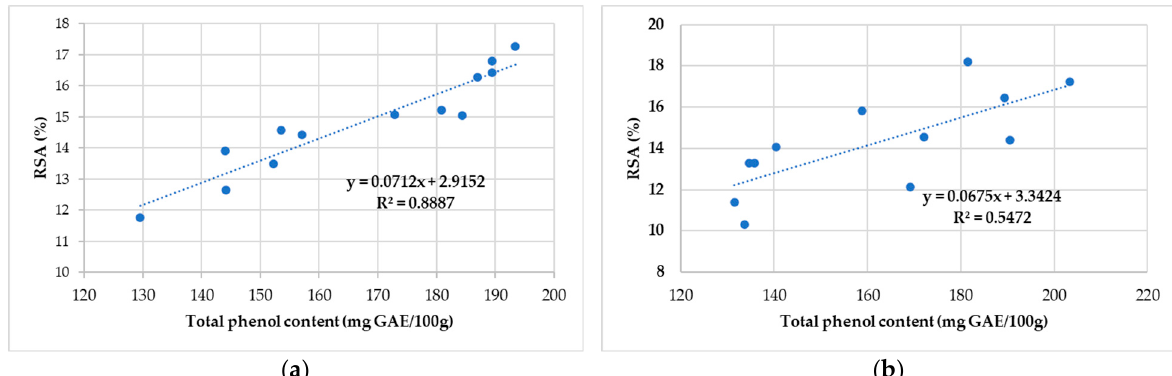
Figure 4. Correlation between antioxidant activity and total phenolic content of the honey sample collected ( a ) from North-West and Central Romania and ( b ) from Alba County.